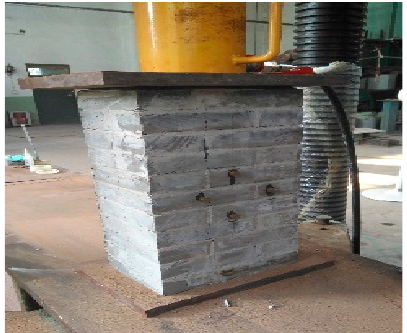
Figure 5. Compressive strength test of the masonry.